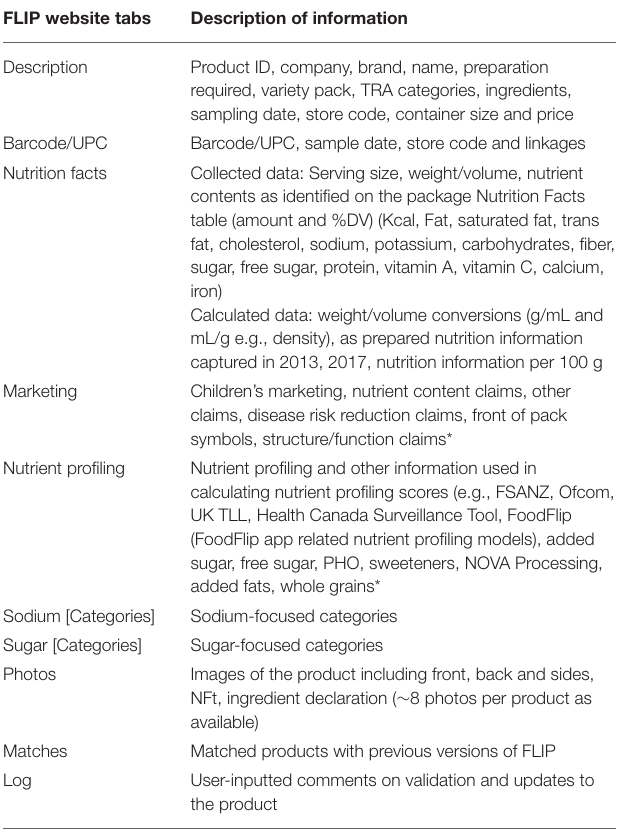
TABLE 2 | Information collected, managed and processed on the FLIP